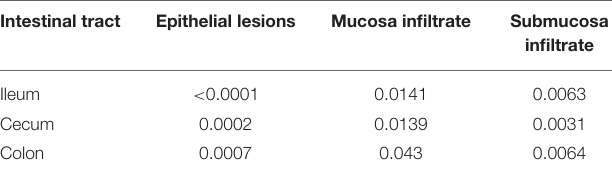
TABLE 3 | Summary results ( p -value) of HE histology analyzed by Kruskal Wallis